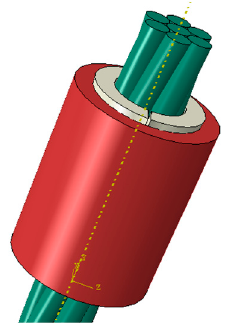
Figure 6. Finite element model of wedge anchorage.